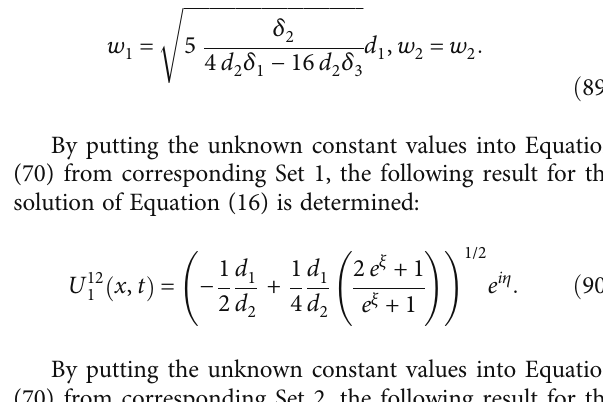
Figure 4: The graphical simulation representation of j U 3 0 : 1, δ = 0 : 6 4